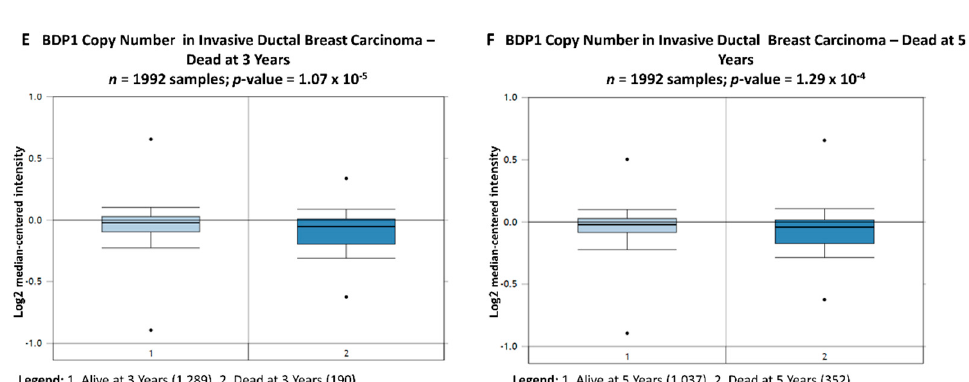
Figure 3. BDP1 alterations negatively correlate with clinical outcomes. Queries of the vandeVijver Breast dataset [48], n = 295 samples, identified significant decreases in BDP1 mRNA expression correlates with clinical outcomes in invasive breast cancer (IBC). ( A ) Comparison of nonmetastatic and metastatic events, at three years; BDP1 mRNA expression is significantly decreased ( − 1.115-fold change), p -value = 7.79 × 10 − 7 ; the gene rank is in the top 1% (47) of 14,719 measured genes in IBC. ( B ) BDP1 mRNA expression is significantly decreased ( − 1.110-fold change), p -value = 4.81 × 10 − 7 , in patients with recurring IBC at three years; the gene rank is in the top 1% (82) of 14,719 measured genes. ( C ) BDP1 mRNA expression is significantly decreased ( − 1.106-fold change), p -value = 9.90 × 10 − 6